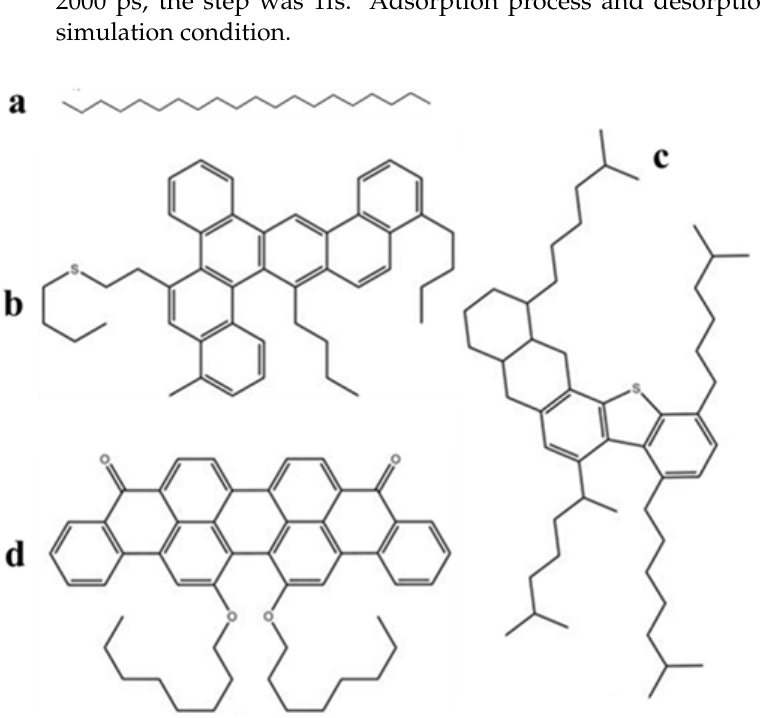
Figure 3. Molecular structures of SARA fractions: ( a ) saturates (C 20 H 42 ); ( b ) aromatics (C 46 H 50 S); ( c ) resins (C 50 H 80 S); ( d ) asphaltenes (C 50 H 48 O 4 ).